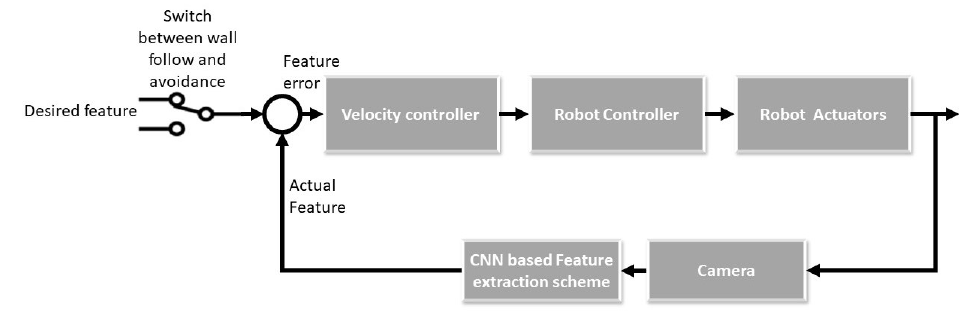
Figure 7. Feedback control loop for wall following.